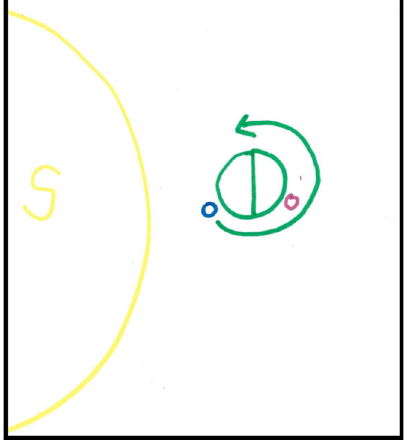
FIG. 9. Karen ’ s Earth-Moon-Sun configuration for waxing crescent and waxing gibbous Moon phase positions with a large circular Earth that has one of Earth ’ s poles facing the